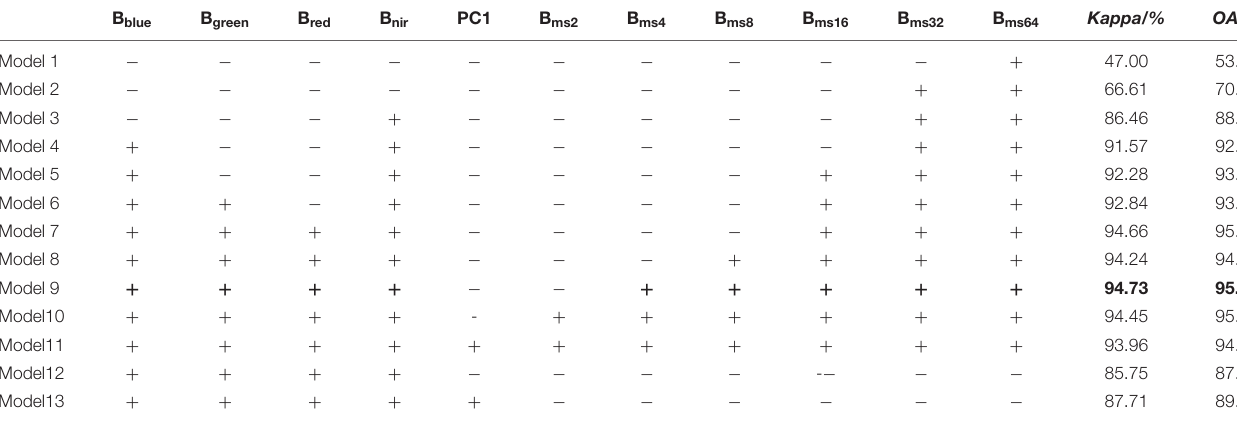
TABLE 2 | The performance of different models based on features combinations.